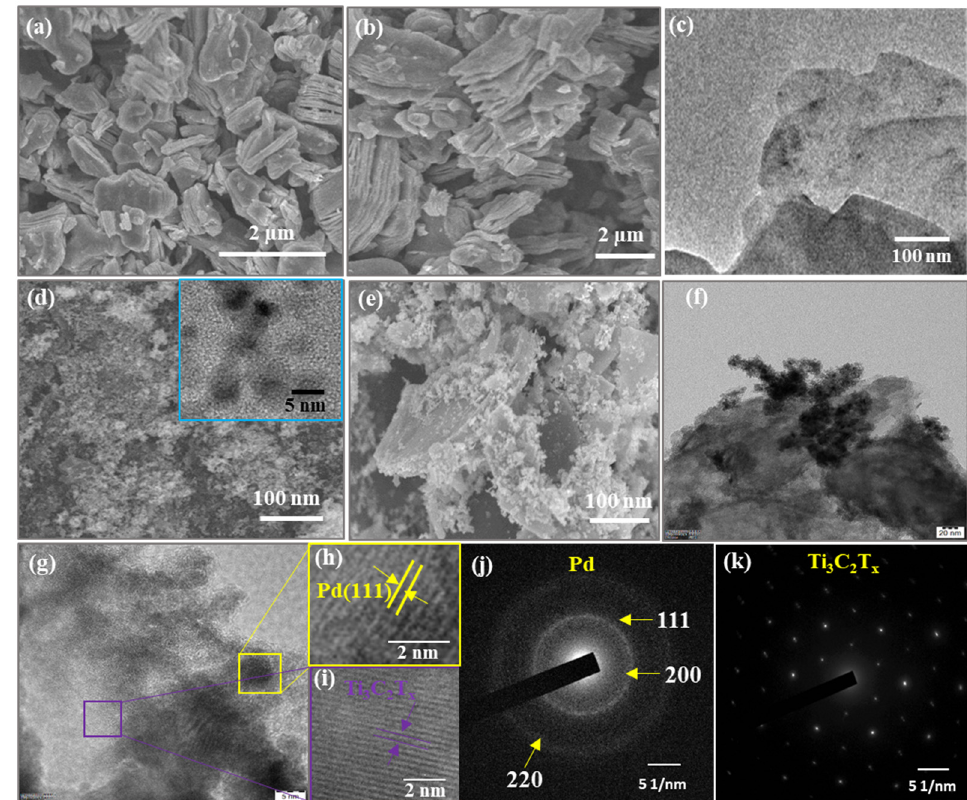
Figure 2. ( a , b ) SEM with different micrographic images of pristine MXene powder, ( c ) TEM image of exfoliated MXene, ( d ) SEM image of Pd NPs with inset of TEM of Pd NPs, ( e ) SEM micrographic image of Pd-MXene nanocomposites, ( f , g ) TEM with different magnification images of Pd-MXene nanocomposites, ( h ) HR-TEM image of individual Pd in the nanocomposites, ( i ) HR-TEM image of MXene (Ti 3 C 2 Ti x ) in the nanocomposites, ( j ) SAED pattern of Pd, and ( k ) SAED pattern of MXene (Ti 3 C 2 Ti x ) in the nanocomposites.